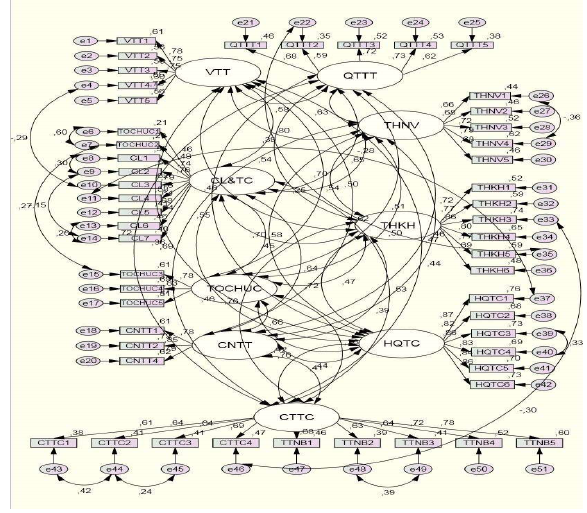
Fig. 1. Results of the CFA model